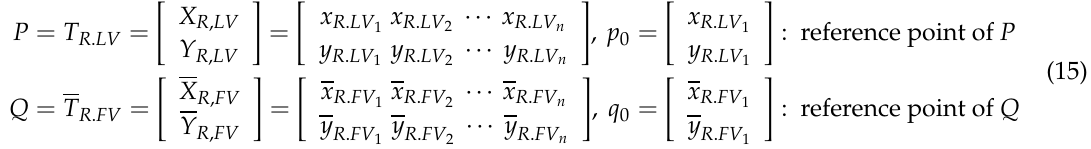
Figure 17. Reference point matching before finding the rotational relationship.